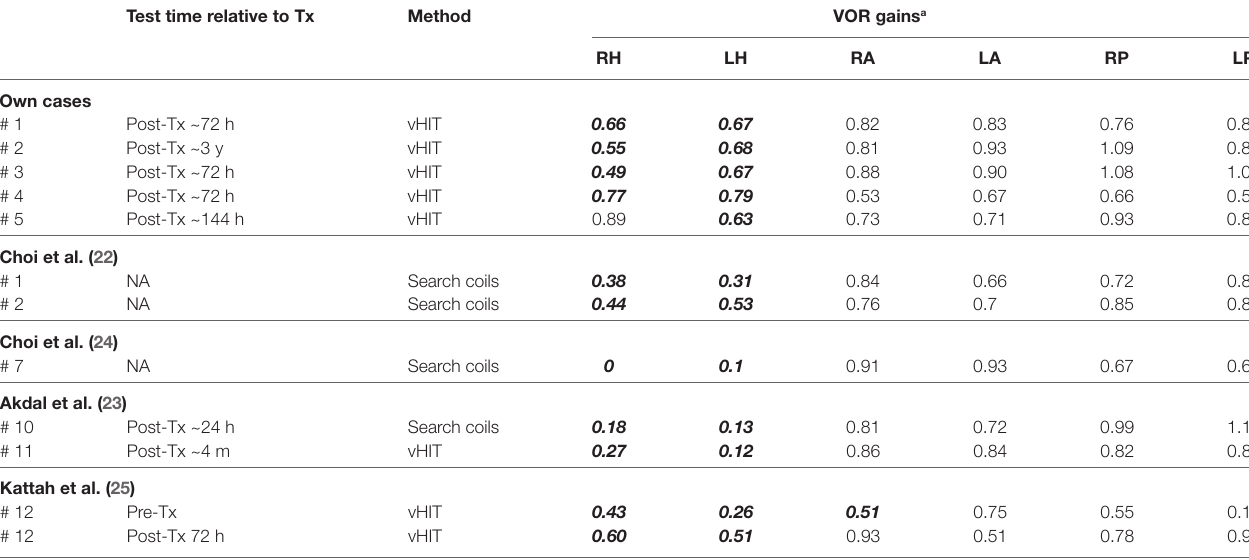
TaBle 4 | VOR gains obtained by head-impulse testing (video-oculography or search-coils) in 11 patients (5 from our series and 6 from the literature review) with Wernicke’s